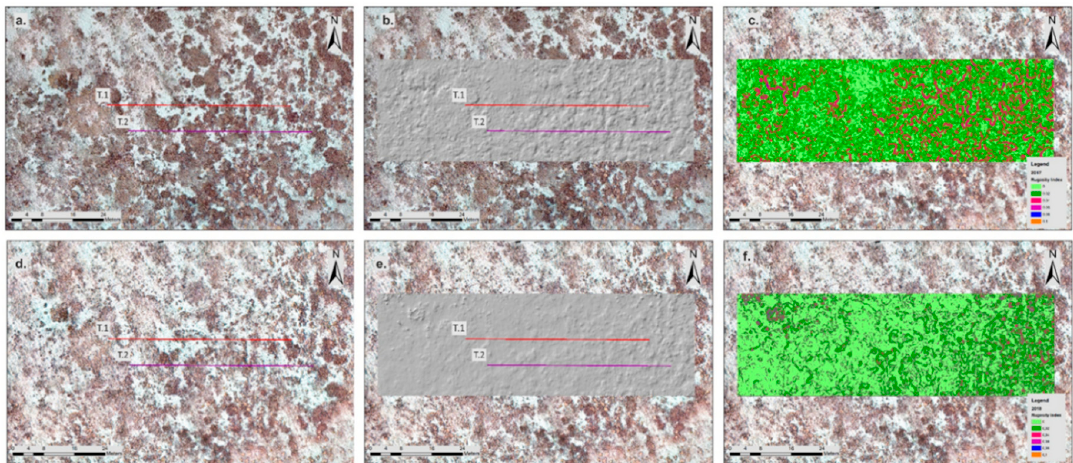
Figure 7. The histogram describes the temporal change (from 2017 to 2018) in the extent of areas with the same rugosity index in the selected portion of Area 4 (Figure 6).